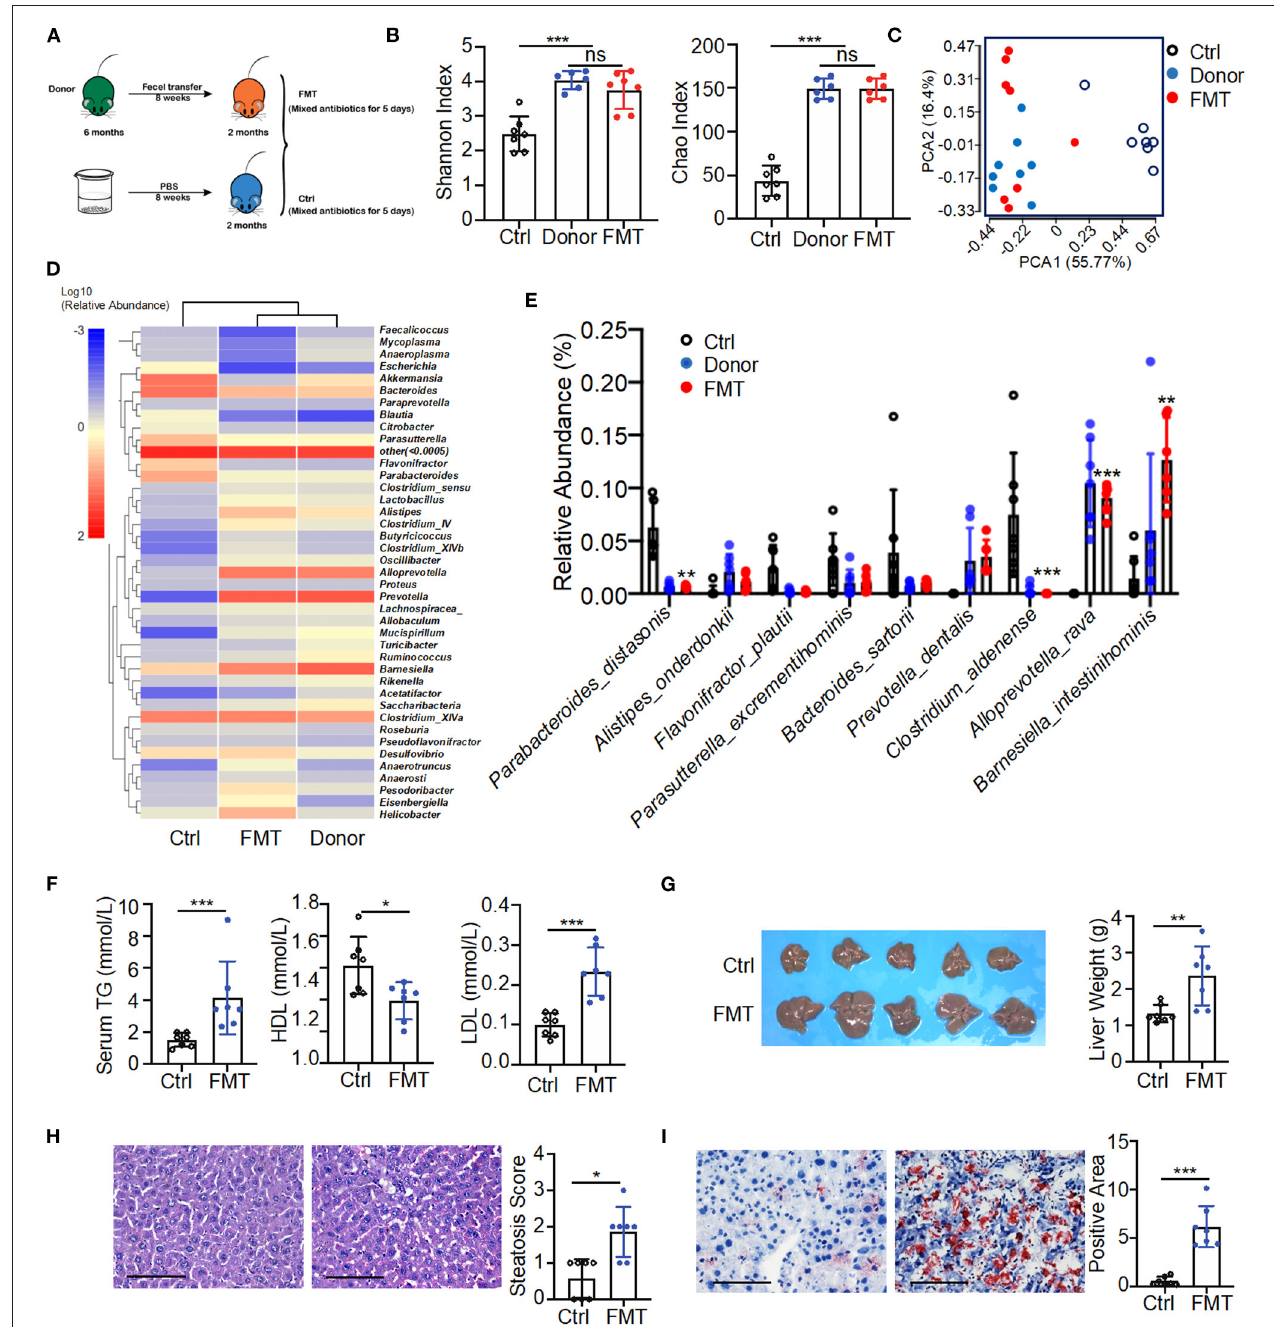
FIGURE 3 | Fecal transfer from 6-month-old K14-VEGF-A-transgenic mice into 2-month-old K14-VEGF-A-transgenic mice exacerbated metabolic disorder. (A) Fecal microbiota transplant experimental design. All 2-month-old K14-VEGF mice were treated with mixed antibiotics for 5 days, then transferred with 6-month-old K14-VEGF mice feces as FMT group, or gavaged with sterile PBS as control group for 8 weeks. (B) Gut microbiota analysis collected from the control, donor, and FMT groups. Plots of Chao1 richness and Shannon index observed in the FMT, donor, and control groups. (C) PCoA plot of the fecal microbiota from the FMT, donor, and control groups ( n = 7 per group). (D) Heat map of differentially expressed fecal metabolites among three groups. Each column represents one group. (E) Gut microbial composition was evaluated in order to determine the relative abundance of species at three groups. (F) Serum TG, HDL, and LDL from the FMT and control group. (G) Liver images and weight of livers. (H) Representative HandE-stained sections and degrees of hepatic steatosis. Scale bar, 100 µ m. (I) Oil Red staining of liver and quantification of hepatic ORO positive area. Scale bar, 100 µ m. Each symbol represented a mouse, and bars showed means and SEM. Statistical tests used were Student t -test in (B,E–I) . * P < 0.05, ** P < 0.01, and *** P <